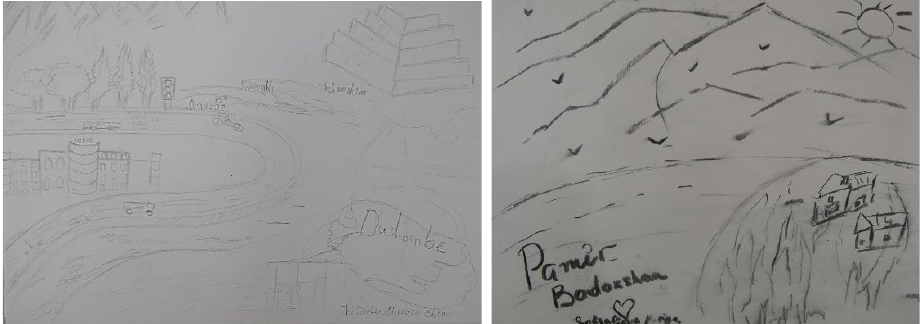
Figure 13. ( a ) A 2021 workshop envisages both cycling and motor vehicles as opportunities to leave the city and explore the Gissar Valley and Mountains; ( b ) again, a 2022 workshop participant pre- sents the regional road infrastructure as an armature for freedom and travel (courtesy of the Young Generation of Tajikistan).